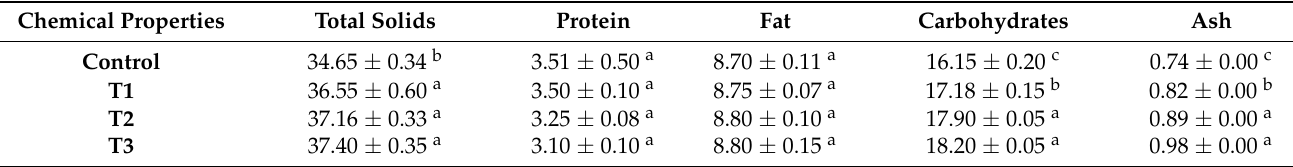
Table 3. Effect of addition of BRP on the main chemical composition (%), physicochemical, and rheological properties of ice cream samples made from camel